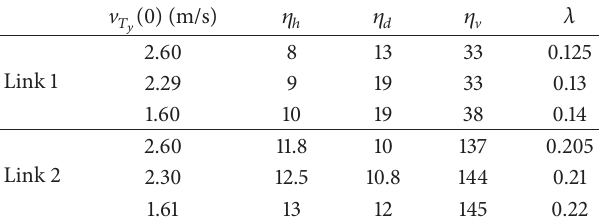
Table 4: The values for the resistance force coefficients 𝜂 ℎ , 𝜂 𝑑 , 𝜂 V , and 𝜆 .